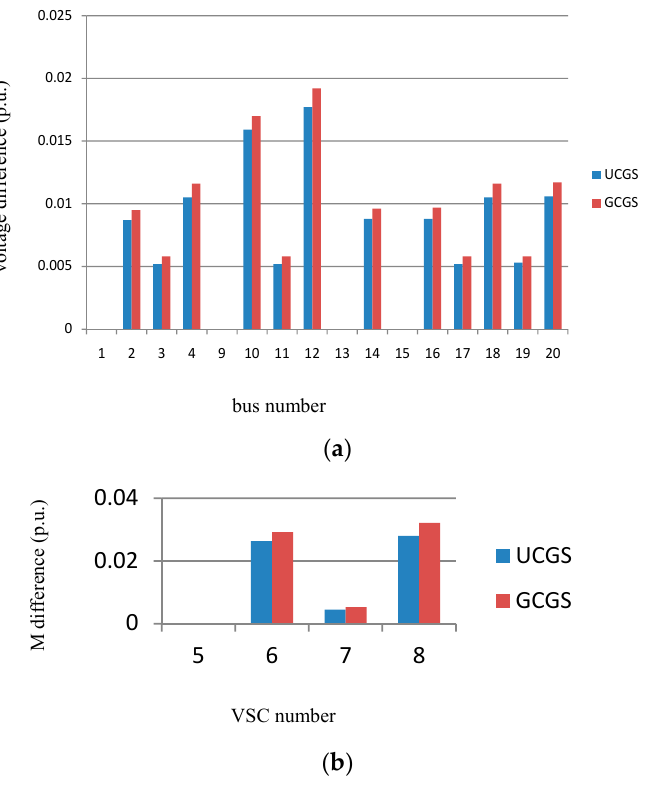
Figure 9. Voltage and M difference for UCGS and GCGS; ( a ) DULVIs for UCGS and GCGS; ( b ) DULMIs for the UCGS and GCGS.